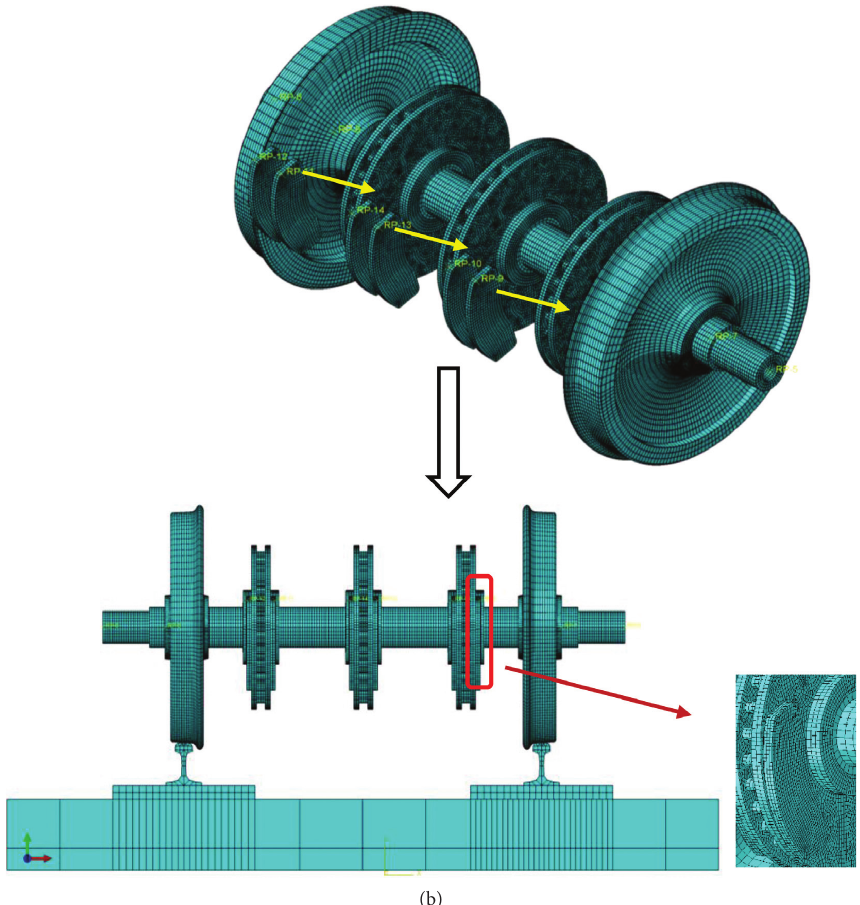
Figure 8: The finite element models of the frictional self-excited vibration of wheelset-track system with the brake coupling: (a) the power wheelset, (b) the trailer